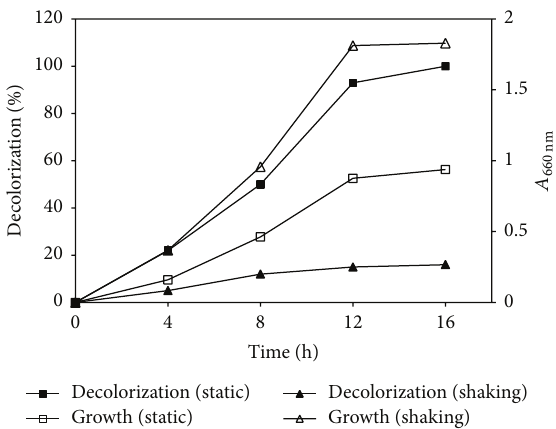
Figure 3: Decolorization of Reactive Violet 5 by Paracoccus sp. GSM2 in MSM under static and shaking condition (120 rpm) at 30 ∘ C.